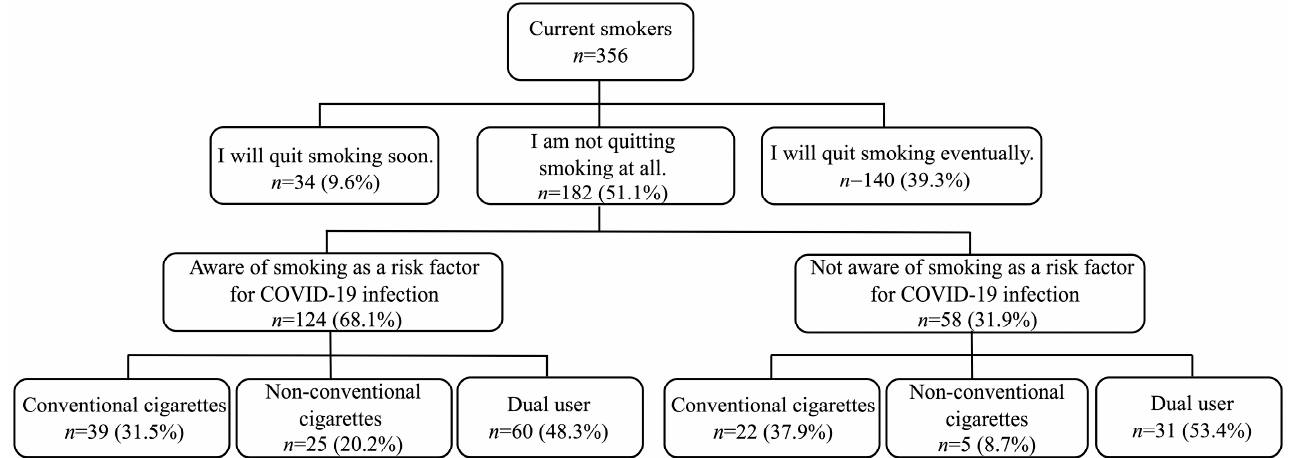
Figure 1. Flowchart of the participants, between March and April 2021, who were undergraduate and graduate students affiliated with a single university in Aichi Prefecture and participated in the questionnaire survey. Conventional cigarettes, cigarettes smokers; non-conventional cigarettes, smokers of heated tobacco products or e-cigarettes; dual users, smokers who use both conventional cigare tt es and non-conventional cigare tt e products.